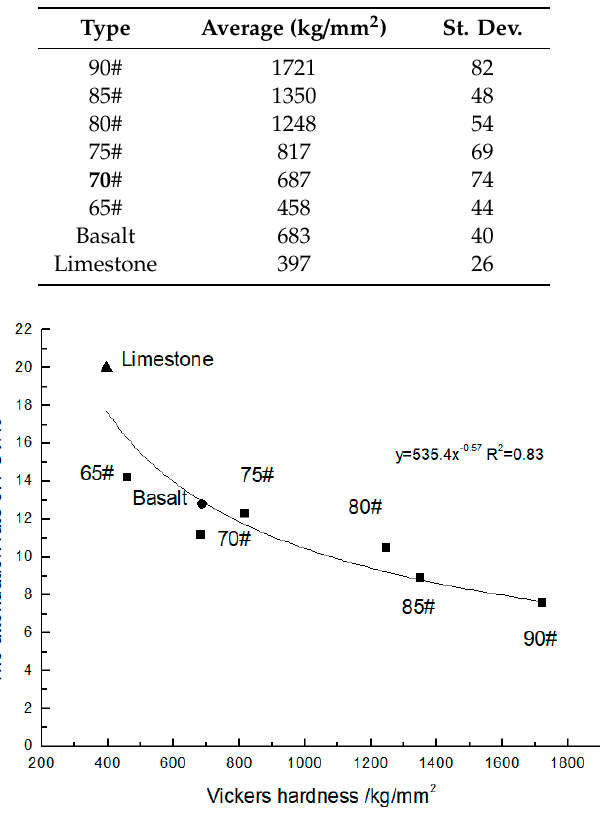
Table 4. Vickers hardness of different aggregates.